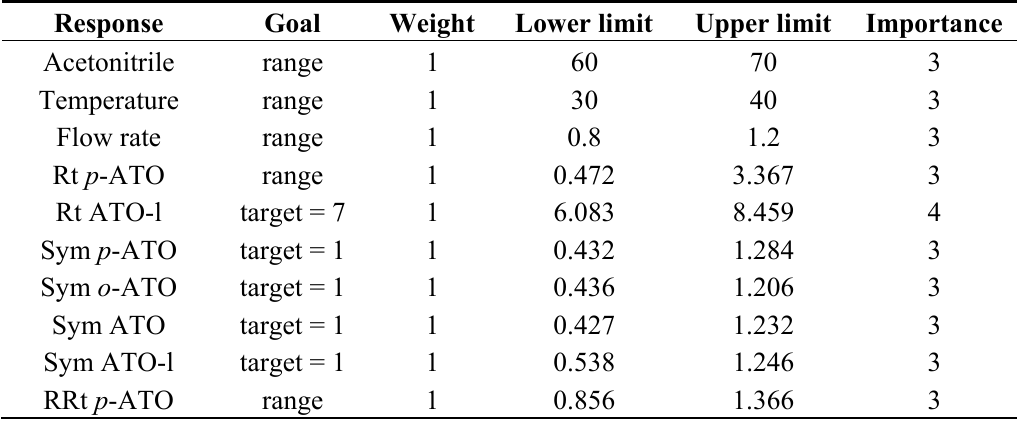
Table 4. Criteria for multivariate optimization of the individual